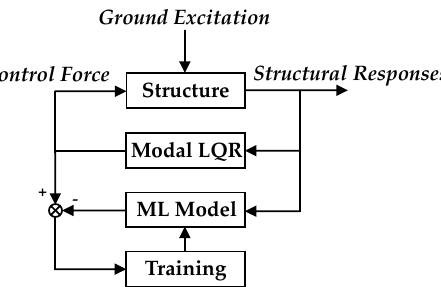
Figure 3. Blocked diagram of the training process. LQR: linear-quadratic regulator; ML: machine learning.